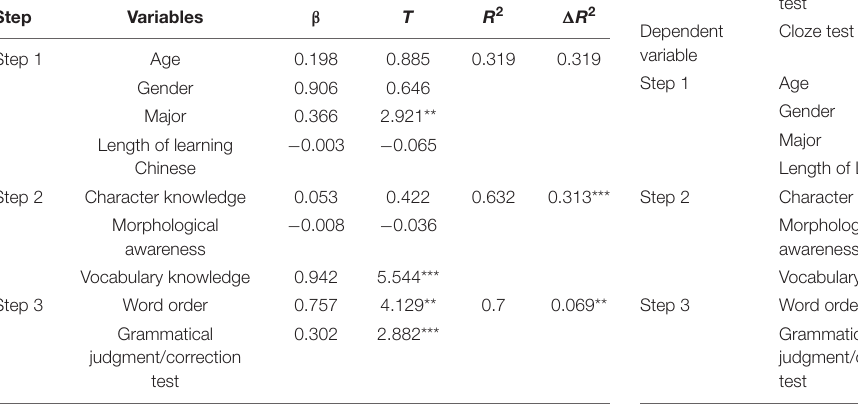
TABLE 3 | Multiple regression analysis predicting passage-level reading comprehension.